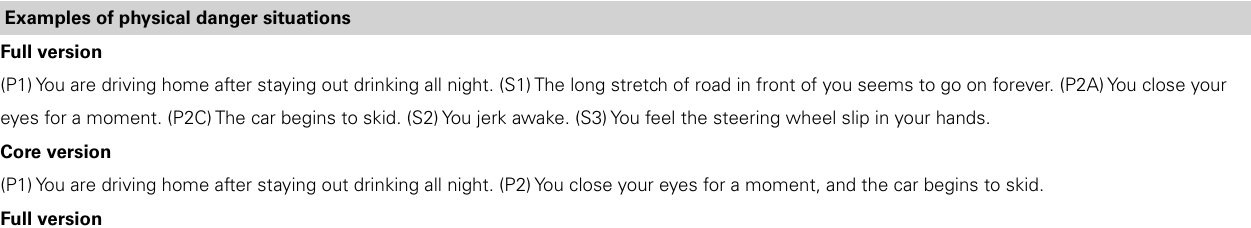
Table 1 | Examples of physical danger and social evaluation scenarios used in the